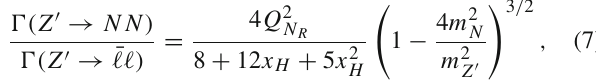
Fig. 1 For the minimal U ( 1 ) X model, the left panel shows the branch- ing ratios of Z (cid:2) as a function of x H with a fixed m Z (cid:2) = 3 TeV. The solid lines correspond to m N 1 = m Z (cid:2) / 4 and m N 2 , 3 > m Z (cid:2) / 2; the dashed (dotted) lines correspond to m N 1 , 2 = m Z (cid:2) / 4 and m N 3 > m Z (cid:2) / 2 ( m N 1 , 2 , 3 = m Z (cid:2) / 4 ). From top to bottom, the solid (red, black and blue) lines at x H = − 1 are the branching ratios to the first generations of jets (cid:9) m 2 used m 2 in the final expression. Similarly, the f L Z (cid:2)